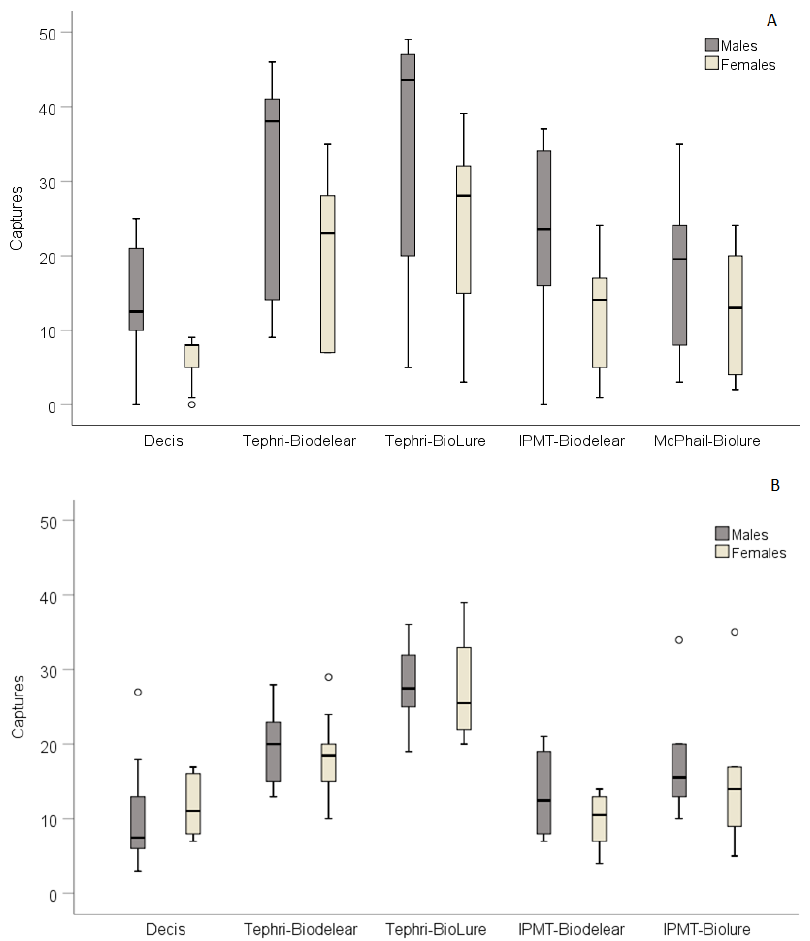
Figure 3. Box plots depicting the percentage of males and females caught in the five mass trapping devices in the field cages trials conducted during spring ( A ) and summer ( B ). A total of 50 males and 50 females were released in each field cage. The GLMs model shows that both the trapping device (x 2 = 251.8, df = 4, p < 0.001) and sex (x 2 = 101.7, df = 1, p < 0.001) were significant predictors of the adult captures during spring trials. The interaction between trapping device and sex was not significant (x 2 = 7.1, df = 4, p = 0.125), suggesting similar sex ratio of the captured adults among trapping de- vices. Tephri traps baited with either BioLure or Biodelear captured the highest number of adults followed by the IPMT traps baited with either BioLure or Biodelear (Table 2, Bonferroni test, p < 0.05). The Decis ® trap captured the lowest number of adults ( p < 0.05). For summer trials, GLMs analysis reveals trapping device as the only significant predictor of adult captures (x 2 = 210.5, df = 4, p < 0.001), as opposed to sex (x 2 = 2.5, df = 1, p = 0.11) and their interaction (x 2 = 6.5, df = 4, p = 0.164). The Tephri trap baited with BioLure out- performed all other trapping devices during summer trials, followed by Tephri trap baited with Biodelear ( p < 0.05). The IPMT trap baited with BioLure captured higher num- ber of adults compared to both the IPMT trap baited with Biodelear and the Decis ® trap ( p < 0.05) that captured similar number of individuals ( p > 0.05).